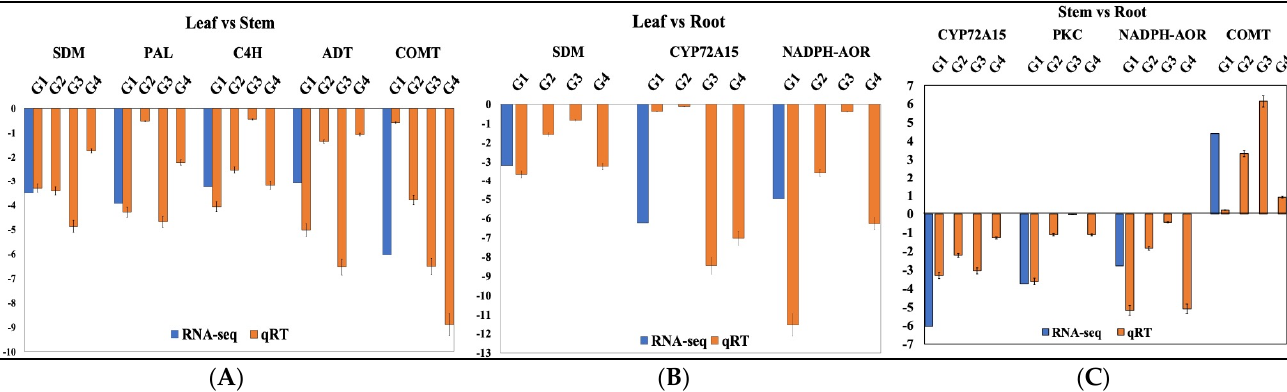
Figure 10. Comparative organ-specific RNA-Seq and qRT-PCR expression profiles of bioactive metabolite pathway-related genes in diverse genotypes from geographically separated populations (G1: Kinnaur_Asrang; G2: Kullu_Kandhaghai; G3: Mandi_Thunag; G4; Kullu_Gulaba) of A. glauca across three combintions: ( A ) leaf vs. stem; ( B ) leaf vs. root; ( C ) stem vs. root. Table 5. Geographical description of four diverse genotypes of A. glauca from Himachal Pradesh. S. No.